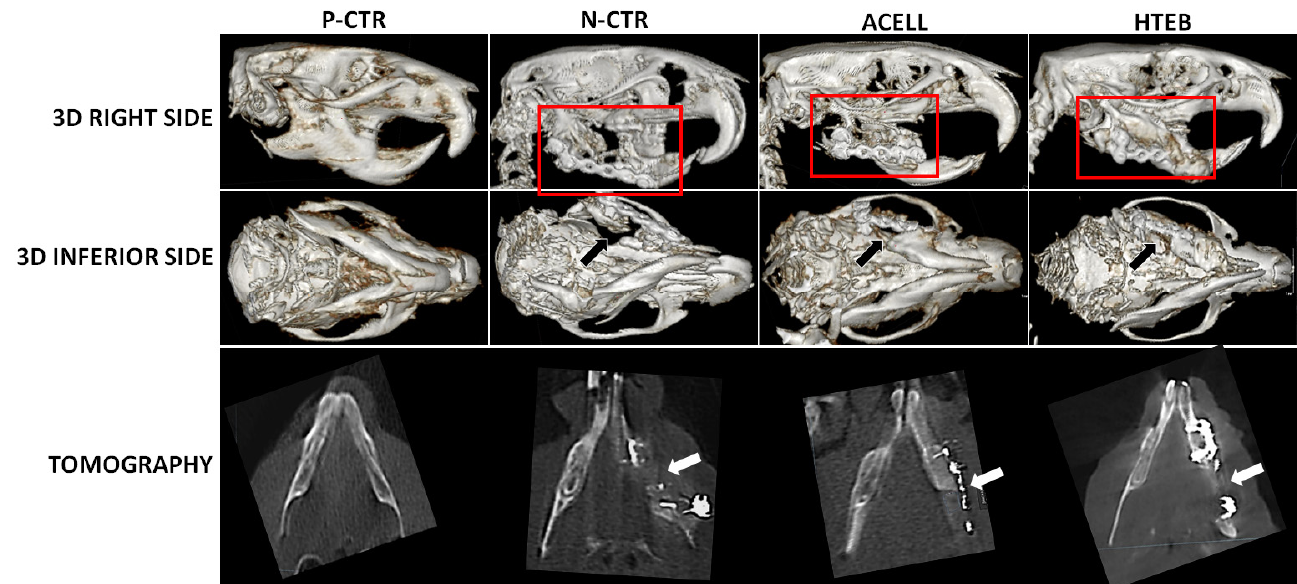
Figure 2. CT scan analysis of the head bones of each group of animals included in the study. Top panels correspond to the 3D reconstruction observed from the right side or from the inferior side, whereas bottom panels show a tomographic section obtained at the axial plane at the site of the defect. P-CTR: native normal animals, used as positive controls; N-CTR: animals subjected to surgical removal of a fragment of the right mandible, used as negative controls; ACELL: animals subjected to surgical removal of a fragment of the right mandible and implant of a nanostructured fibrin–agarose biomaterial; HTEB: animals subjected to surgical removal of a fragment of the right mandible and implant of a nanostructured human tissue-engineered bone substitute.